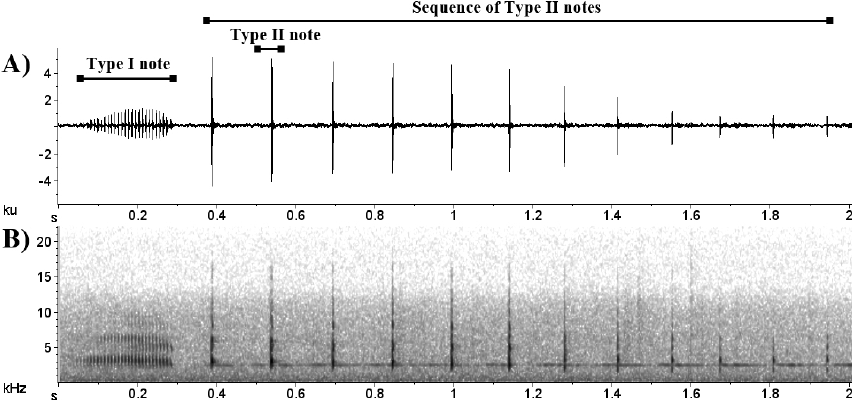
Figure 3. Advertisement call of Eleutherodactylus bilineatus (MZFS 600). ( A ) Waveform and ( B ) audio- spectrogram. Recorded on April 21, 1997 at 20h 50min. Air temperature during recording 20°